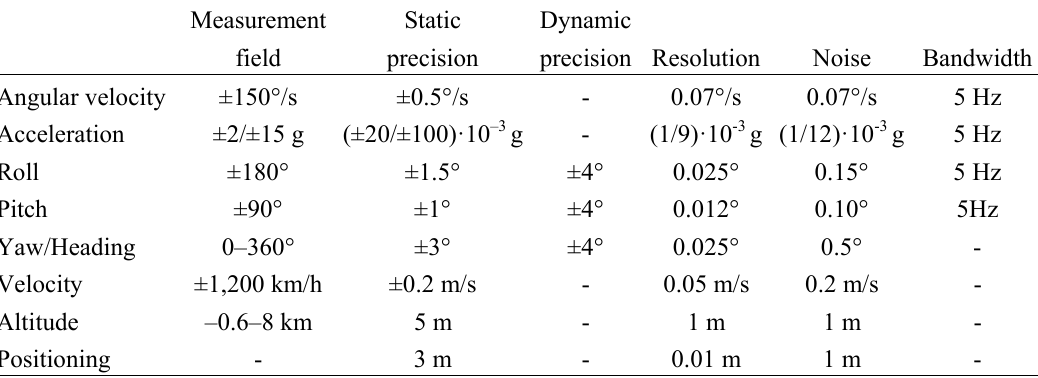
Table 5. Sensing specifications of the AXIS-AIS402 inertial measurement